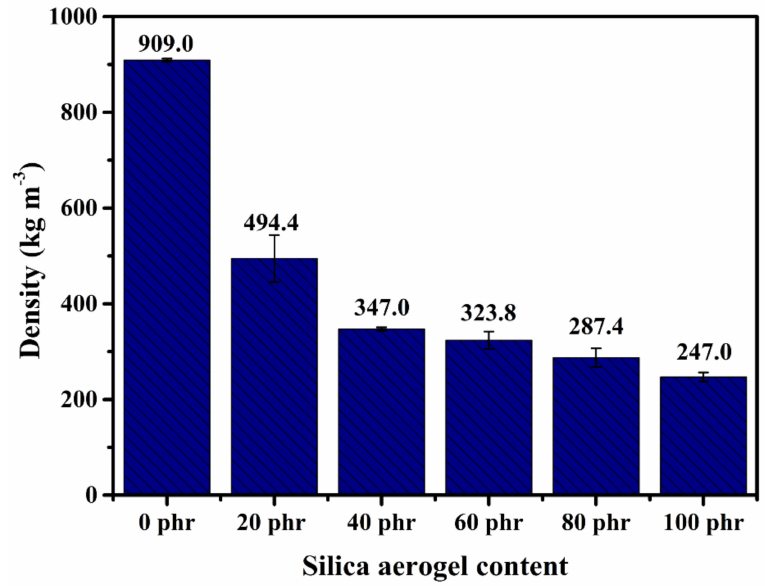
Figure 7. Density of silica aerogel/NR composites in different silica aerogel contents and NR